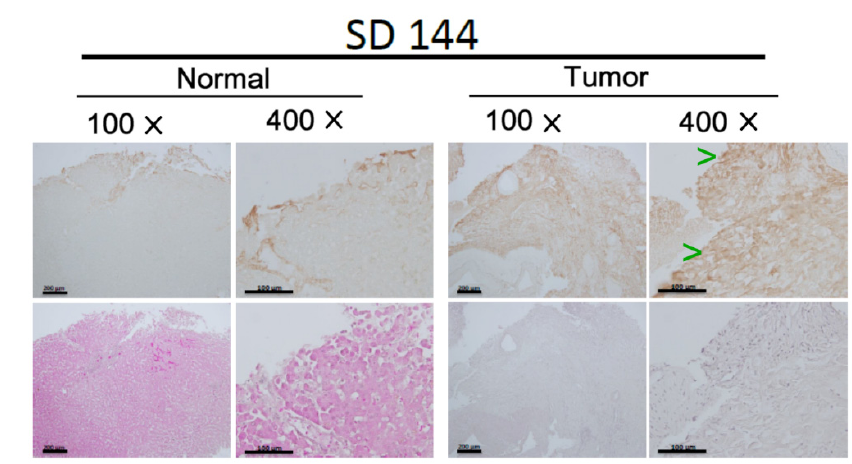
Figure 2. IHC of Hic-5 on tumor and normal counterpart of CCA. IHC of Hic-5 on tissue section in CCA (tumor) and normal counterpart (normal). H. E. stains for each sample are included on the low panels of each figure. Green arrowheads indicate the locations of high Hic-5 staining (brown color) in the peripheral region of each tumor tissue, photographed under 100- and 400-fold of magnification.